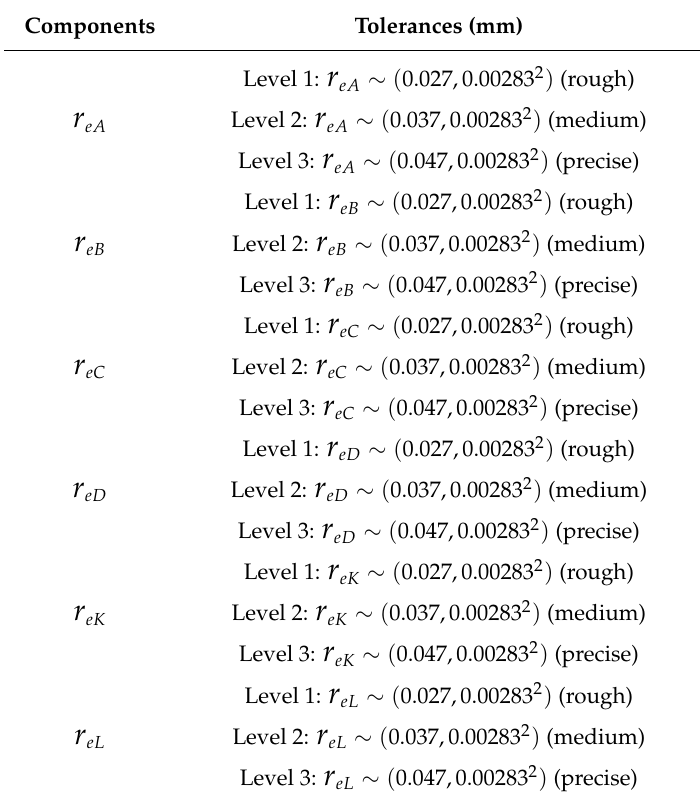
Table 5. Tolerances and experiment